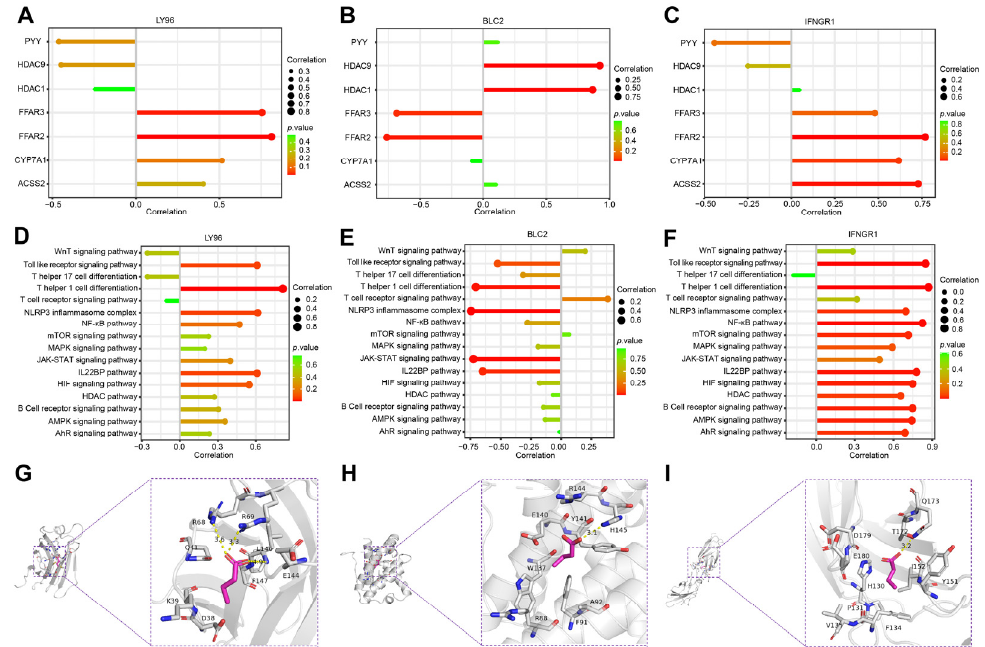
Figure 8. Correlation of hub genes with SCFAs in SAP patient samples analyzed using ssGSEA. ( A – C ) Lollipop plots of three hub genes with genes related to the metabolism of SCFAs. ( D – F ) Lollipop plots of three hub genes and the star pathway associated with the metabolism of SCFAs. ( G – I ) Molecular docking assemblies of three hub genes interacting with butyric acid. Hub genes ( LY96 , BCL2 , IFNGR1 ) interact with butyric acid mainly through hydrogen bonding and hydrophobic forces, with binding energies of − 3.9 kcal/mol, − 3.5 kcal/mol, and − 3.9 kcal/mol, respectively. The lower the binding energy, the stronger the